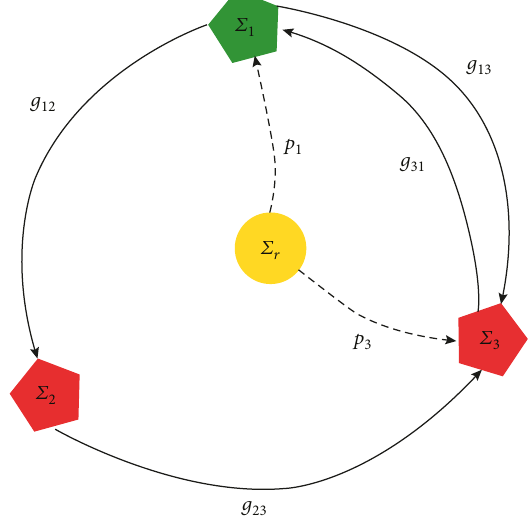
Figure 9: Connection graph for the case in which ρ = g = 0 g 21 32